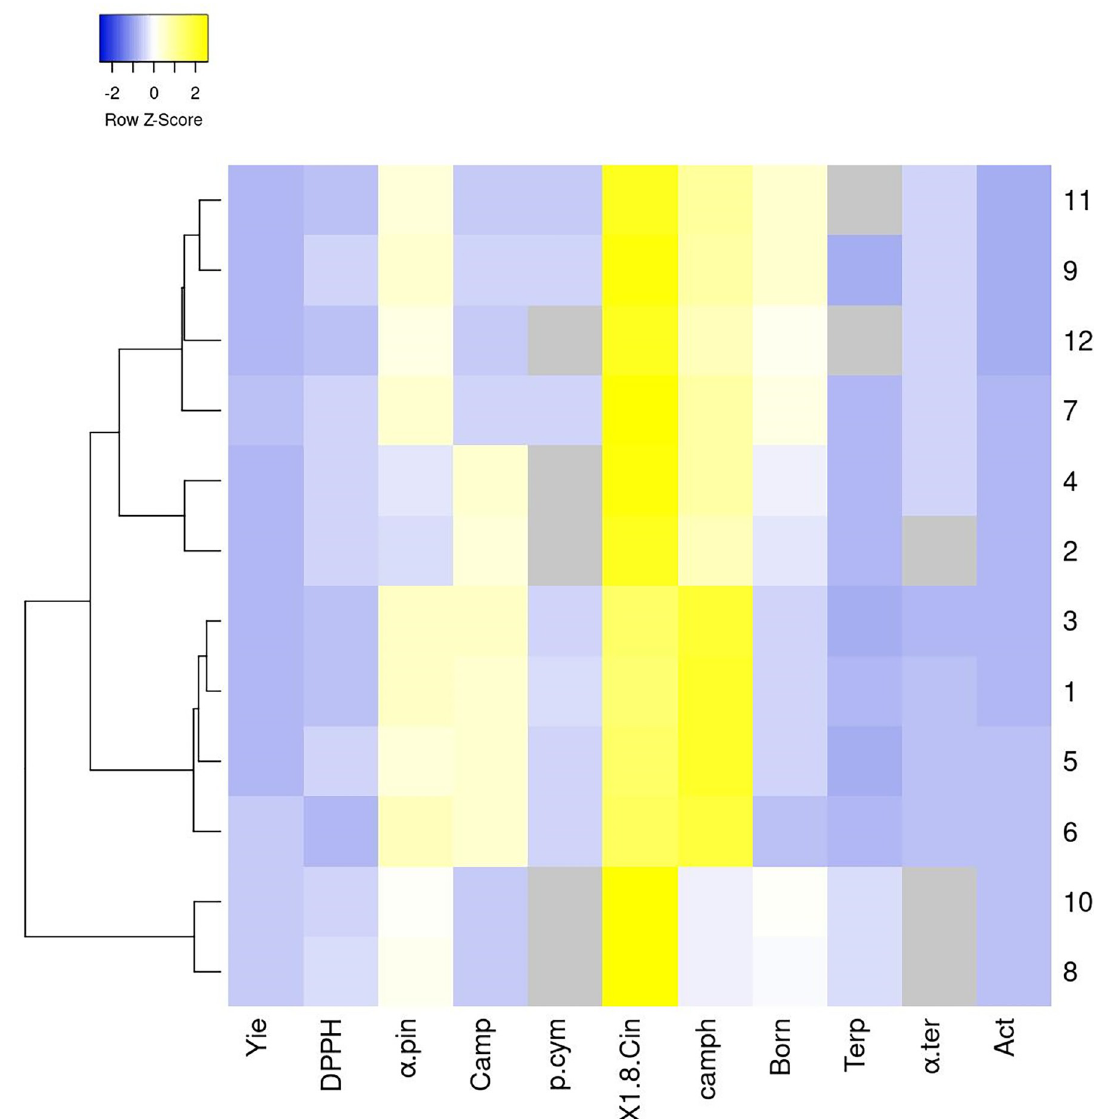
Fig 5. Heatmap plot of Rosmary samples and major essential oil compounds using color